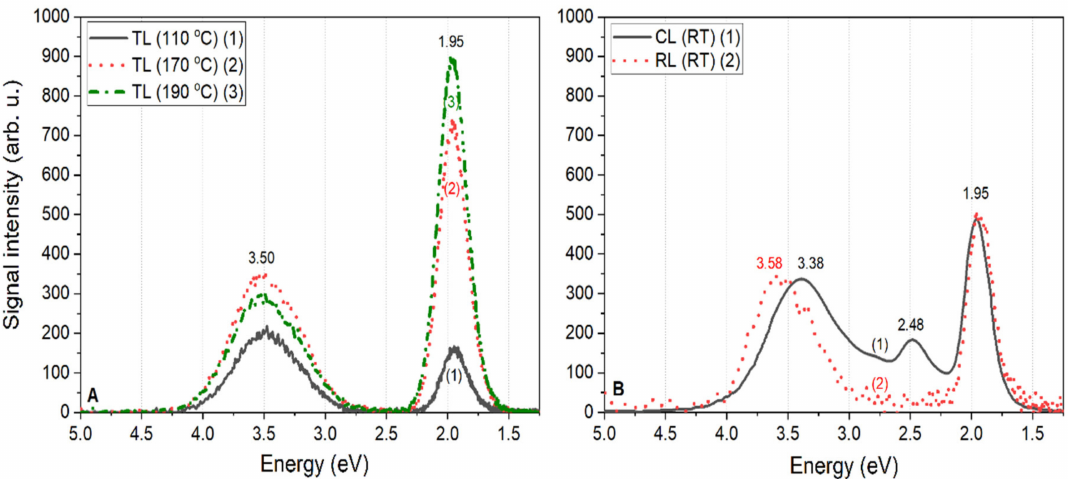
Figure 3. Intrinsic defect-related luminescence spectra measured for nominally undoped LiMgPO 4 crystals under the di ff erent modes of stimulation: thermoluminescence (TL) ( A ), and cathodoluminescence (CL) and radioluminescence (RL) ( B ). One should note that the CL and RL spectra were normalized, and thus their intensities should not be directly compared to the intensities of the TL